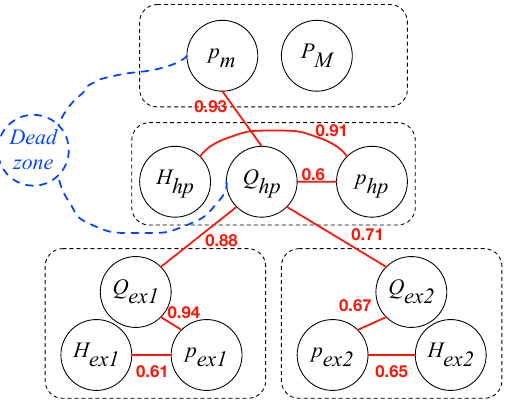
Figure 7. Completed graph ˆ